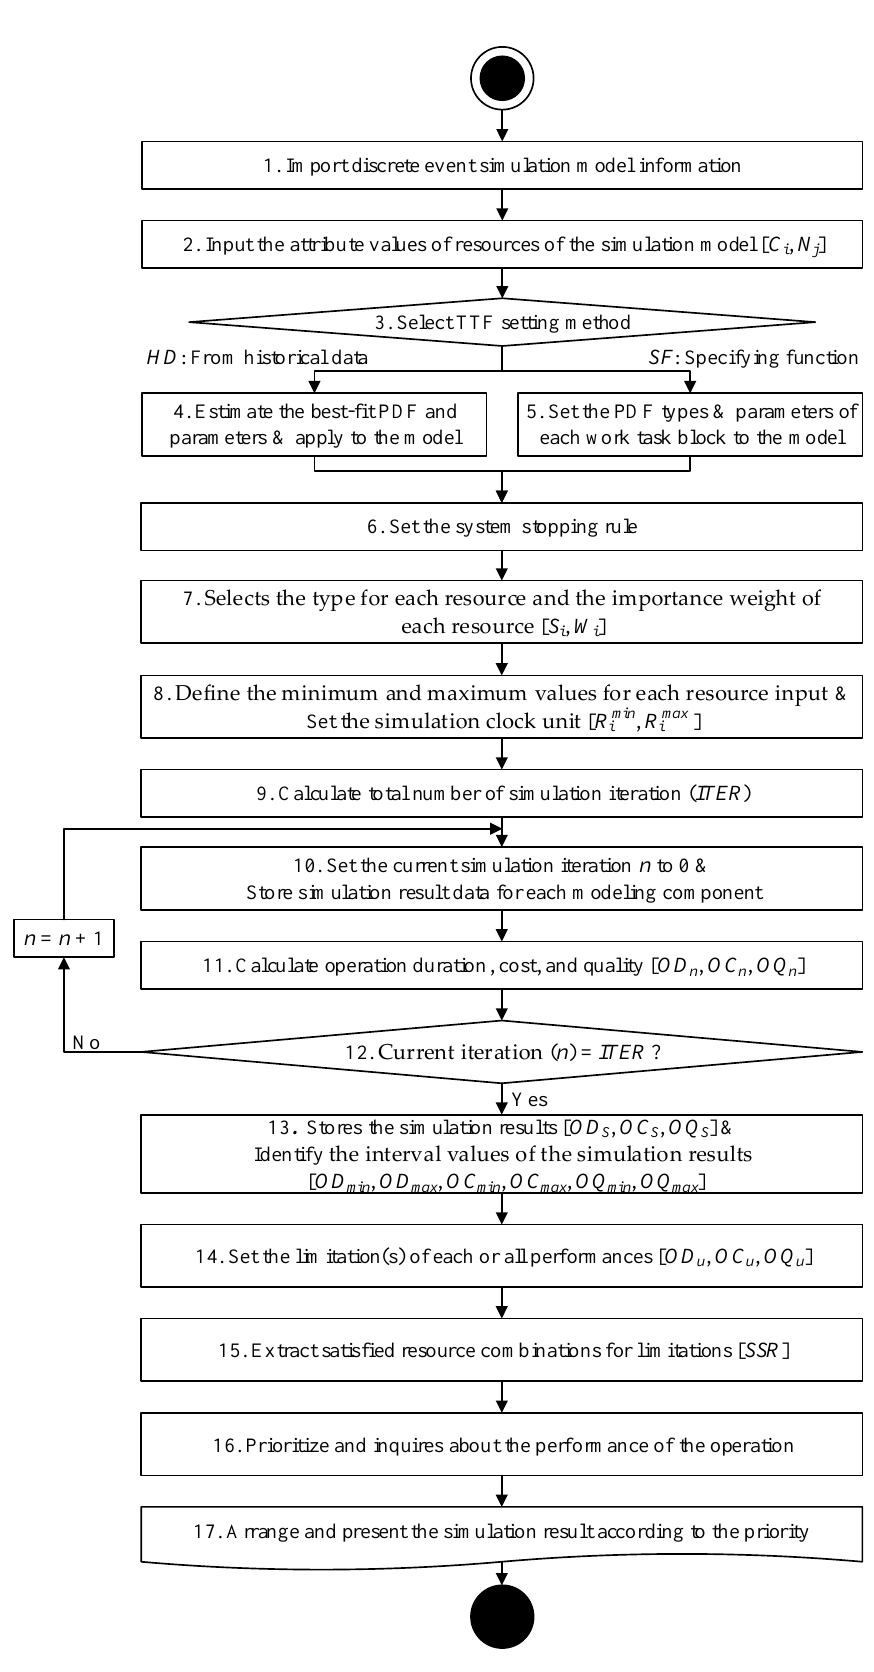
Figure 1. System process.